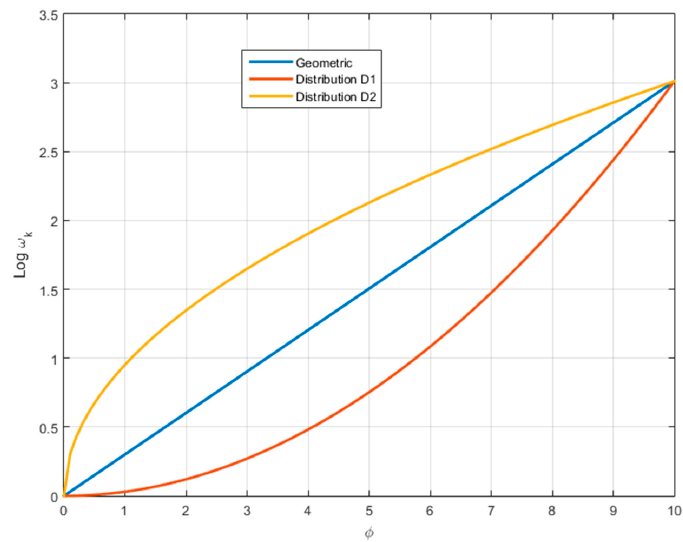
Figure 6. Two examples of pole distributions compared to the geometric one.